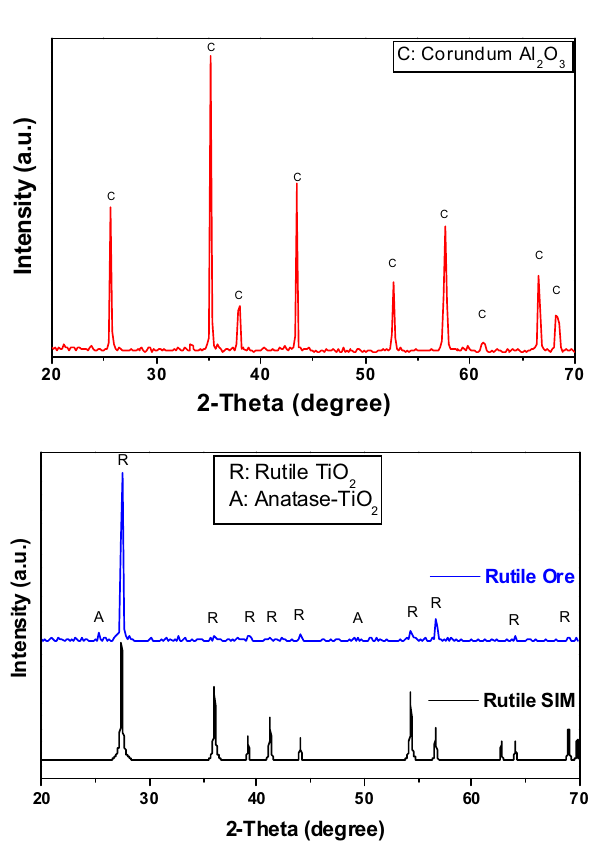
Figure 1. XRD patterns of the starting materials: calcined alumina ( a ) and rutile ore ( b ).